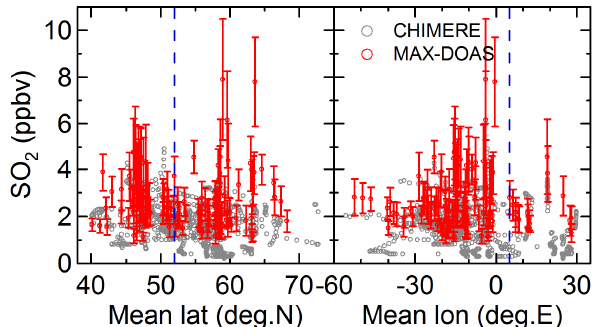
Fig. 15. SO 2 VMRs from MAX-DOAS (red) and CHIMERE (gray) plotted against mean latitude and longitude of the 10-day back trajectories. Error bars represent the error range of MAX-DOAS SO 2 VMR data. The location of Cabauw is indicated by vertical dashed lines.